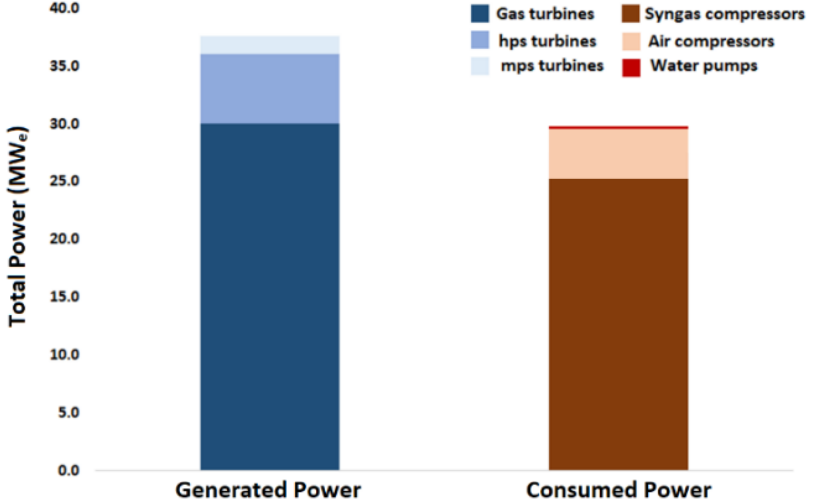
Figure 11. Amount of power generated/consumed by the process.